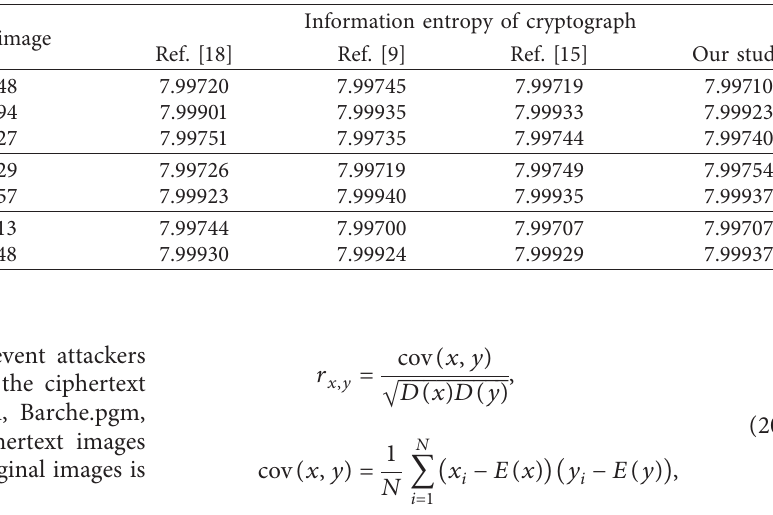
Table 5: Information entropy analysis